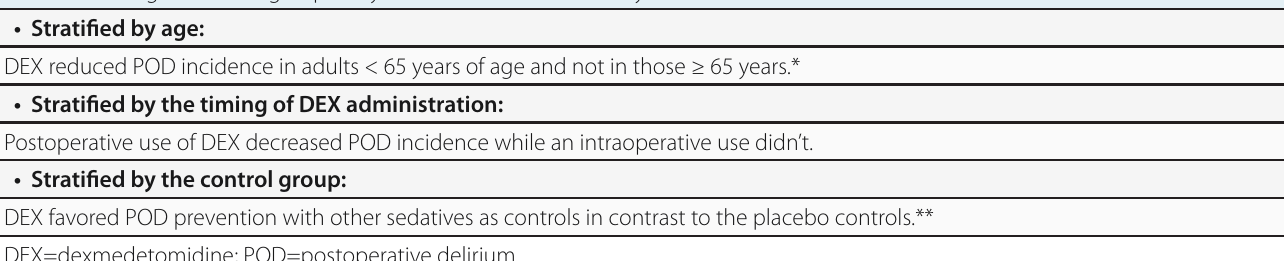
Table 1. Findings of the subgroup analysis of the Li et al. meta-analysis [9]